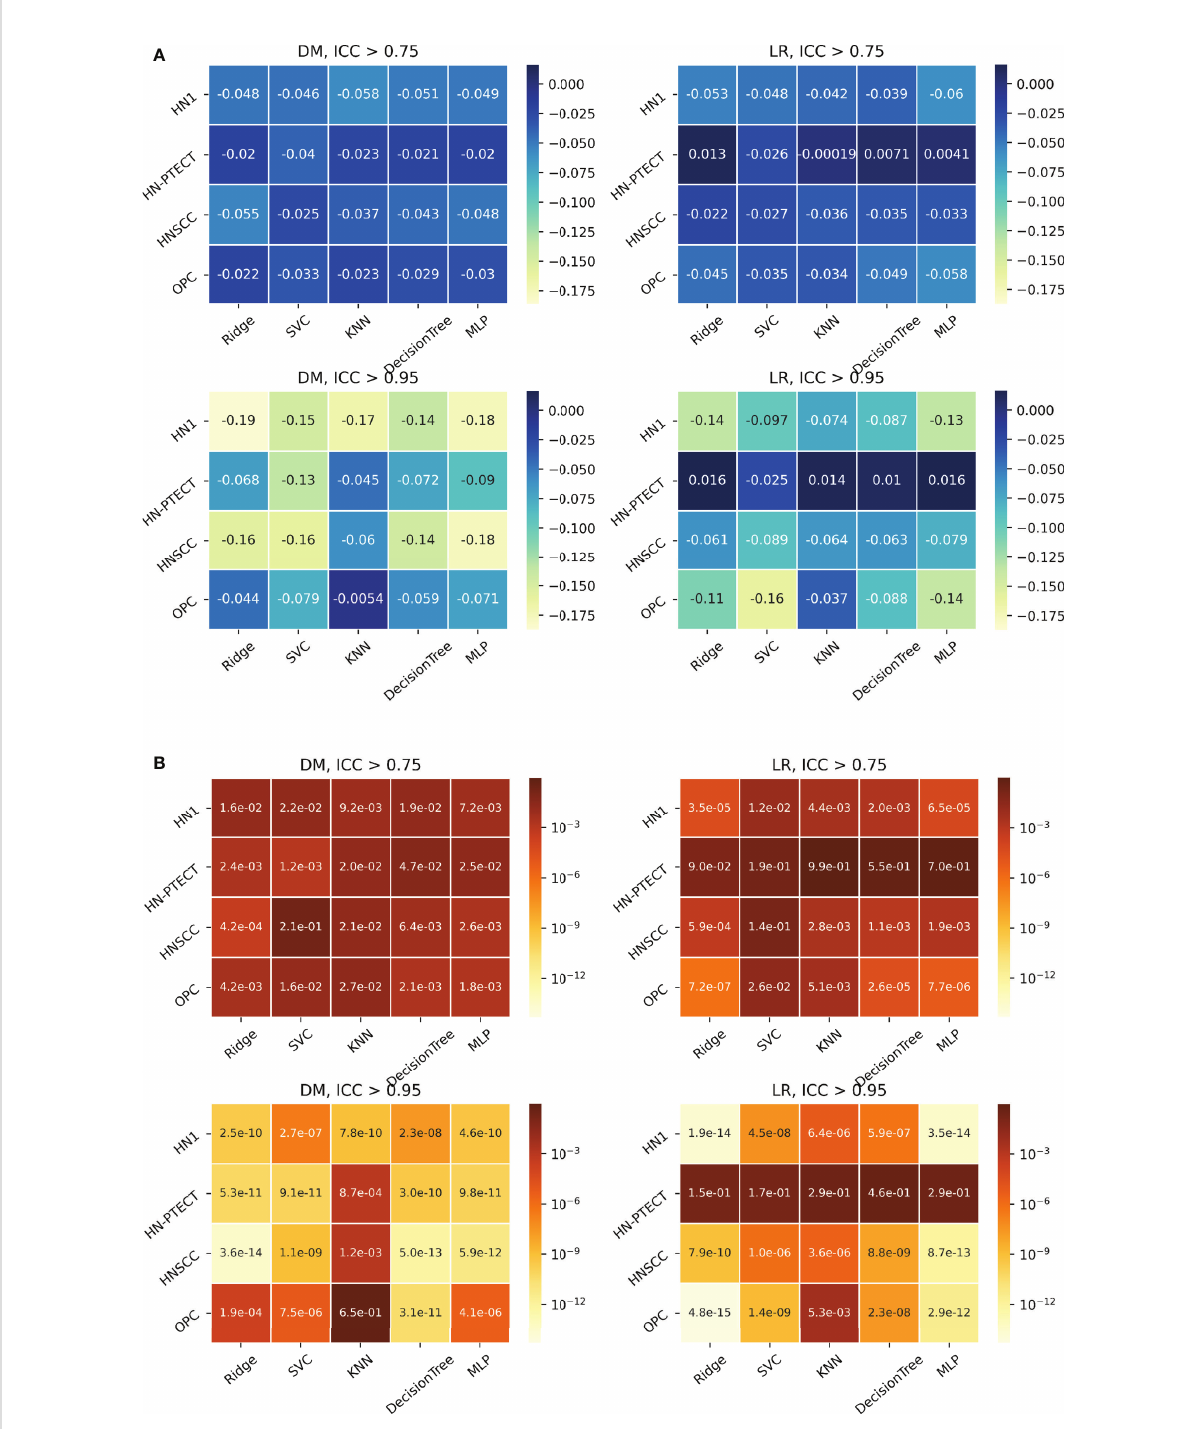
FIGURE 6 Heatmaps on mean model generalizability improvements (A) and statistical test results (B) after feature robustness fi ltering. Model generalizability is de fi ned as the difference between training and testing AUCs, AUC testing - AUC training . A score closer to zero shows better generalizability. In general, model generalizability improved after feature robustness fi ltering, as shown by the negative values on the heatmaps (A) for both fi ltering thresholds. Greater improvements were observed with the higher fi ltering threshold (ICC > 0.95). Moreover, more signi fi cant differences are shown by the smaller P-value. However, the predictions of LR on the dataset HN-PETCT showed worse generalizability after feature robustness fi ltering and the opposite trend of generalizability change and statistical test results with increasing fi ltering